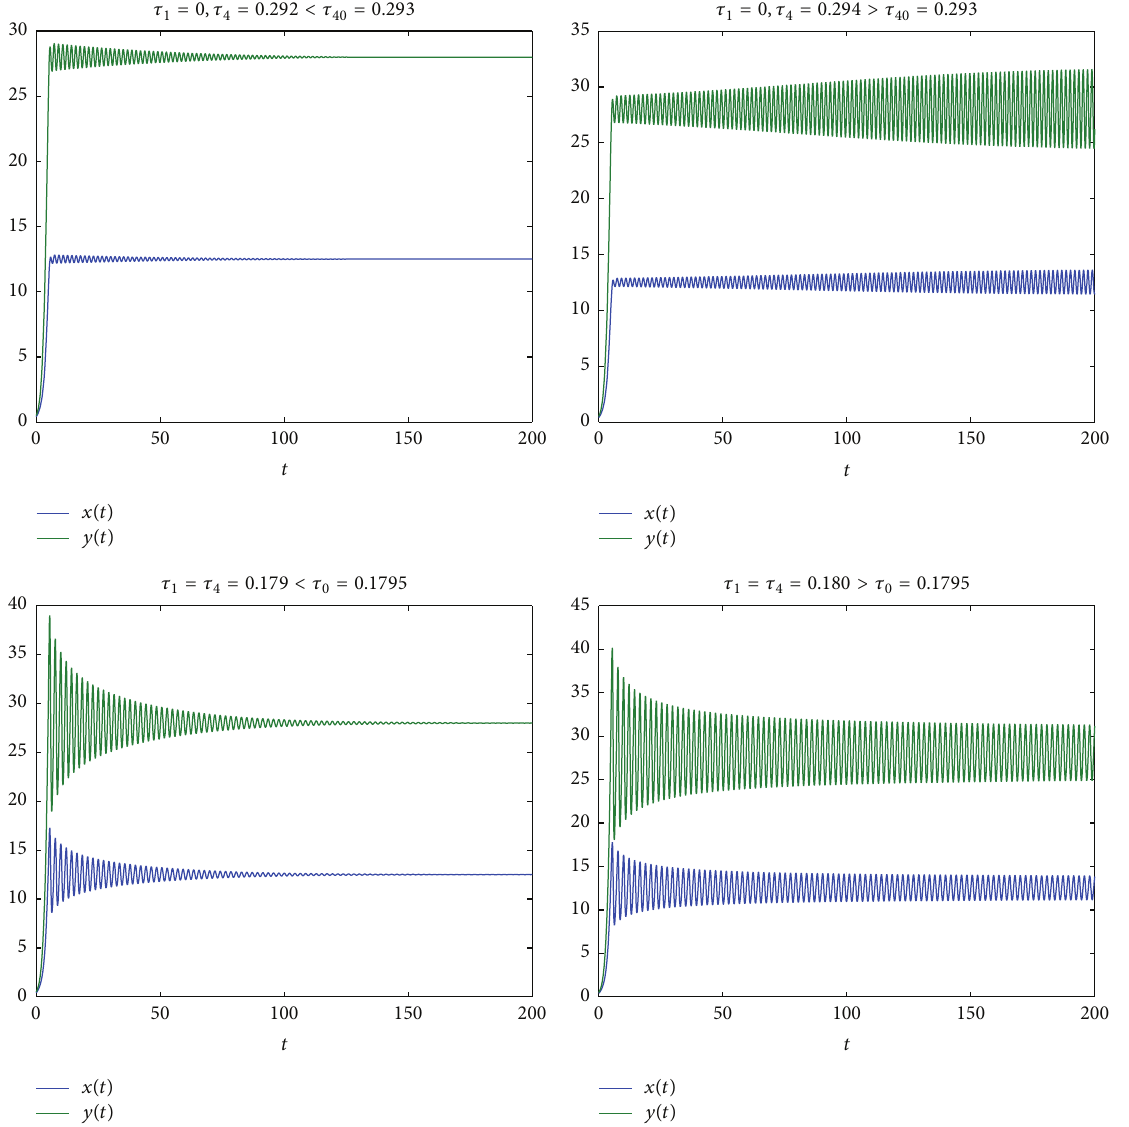
Figure 4: MATLAB simulation shows that system (115) undergoes a Hopf bifurcation at 𝐸 ∗ once 𝜏 4 > 𝜏 40 = 0.293 and 𝜏 1 = 𝜏 4 > 𝜏 01 = 0.1795 , respectively, with initial value “0.4,